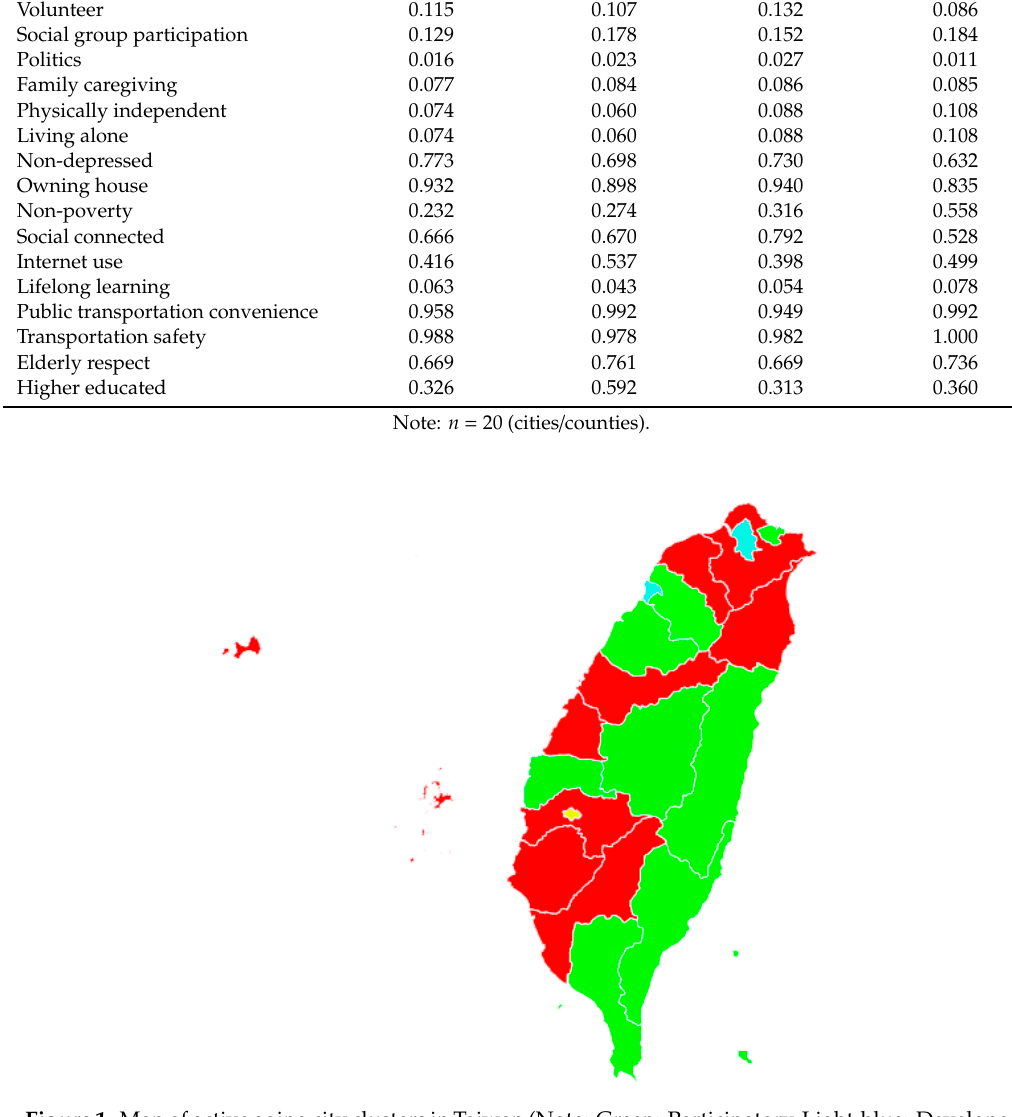
Figure 1. Map of active aging city clusters in Taiwan (Note: Green: Participatory, Light-blue: Developed; Red: Content; Yellow: Pioneer).